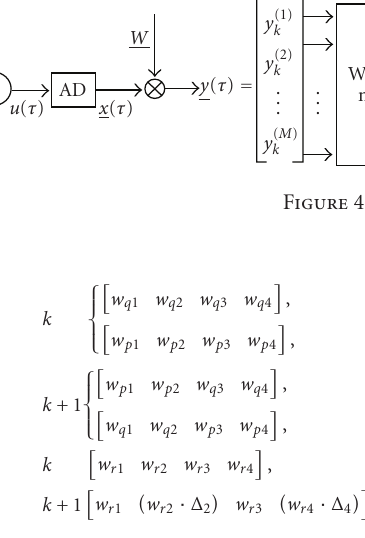
Figure 5: Example for crossover and mutation operators in case of chromosomes composed by four genes.